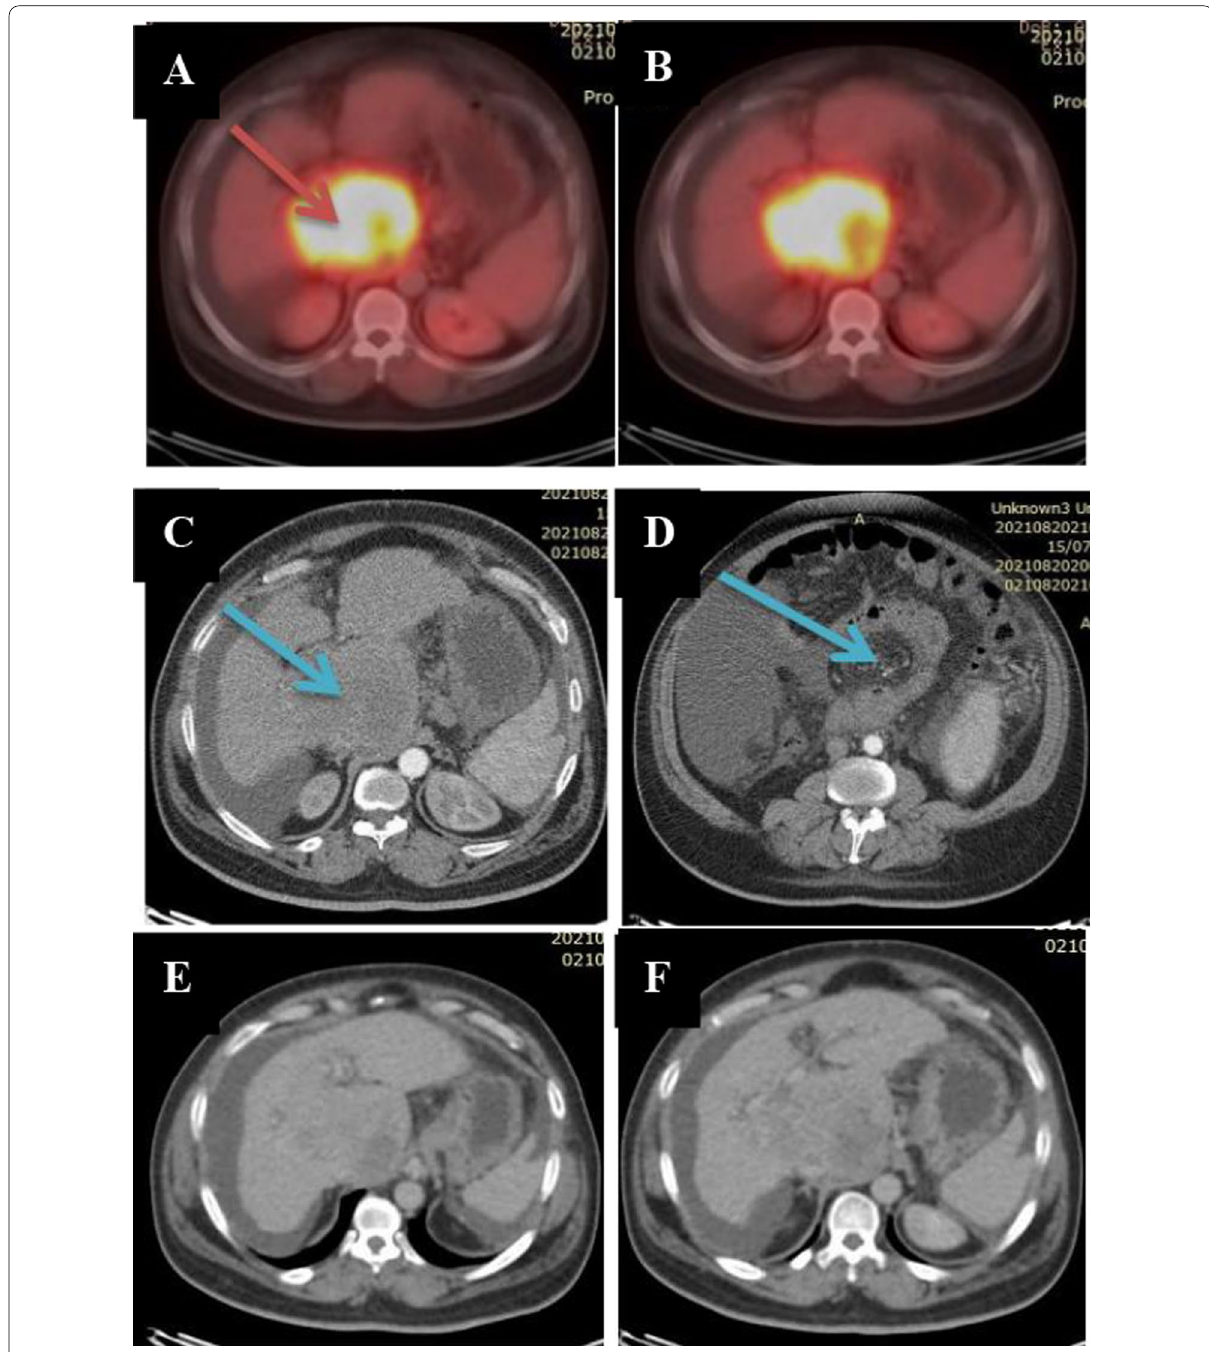
Fig. 2 A 62-year-old male with known HCC, triphasic CT showed cirrhotic liver with ascites and HFL with criteria of HCC, which was proved also by PET/CT. A , B , G 18F FDG PET/CT images showing a metabolically active lesion at caudate lobe (red arrow) measuring about 11 SUV max of 13.92. C – F triphasic CT showing the lesion with early arterial heterogenous enhancement with areas of break down and cystic